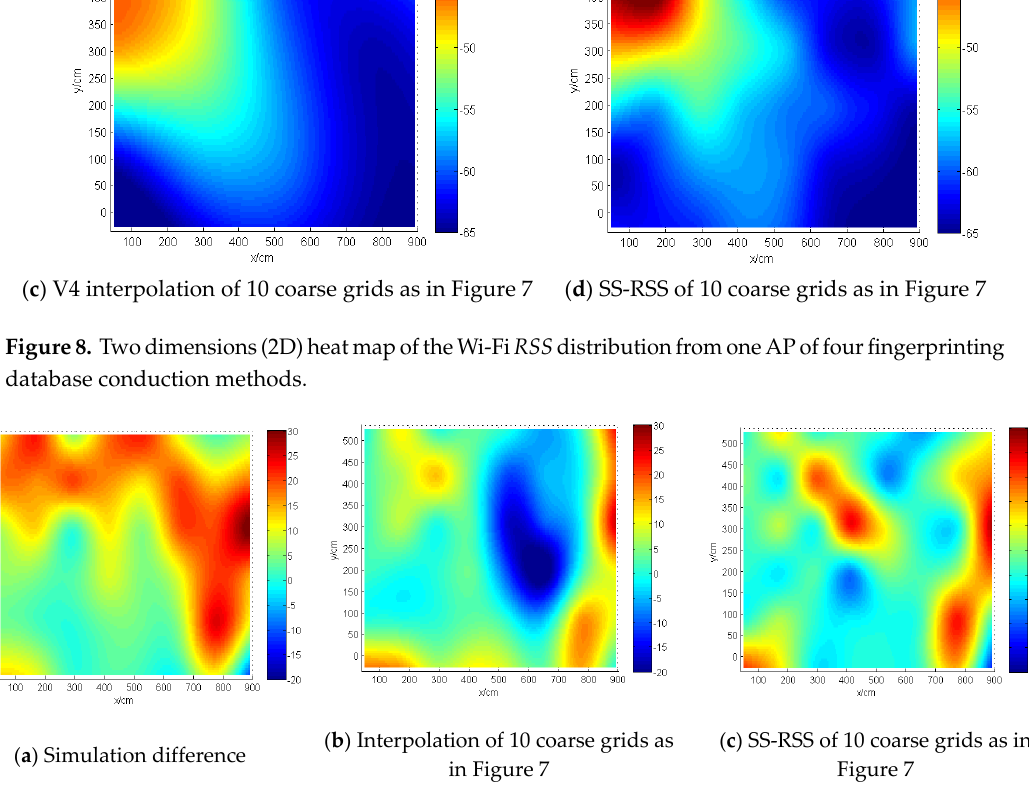
Figure 9. 2D heat map of the average RSS difference (diff) from 5 Aps.